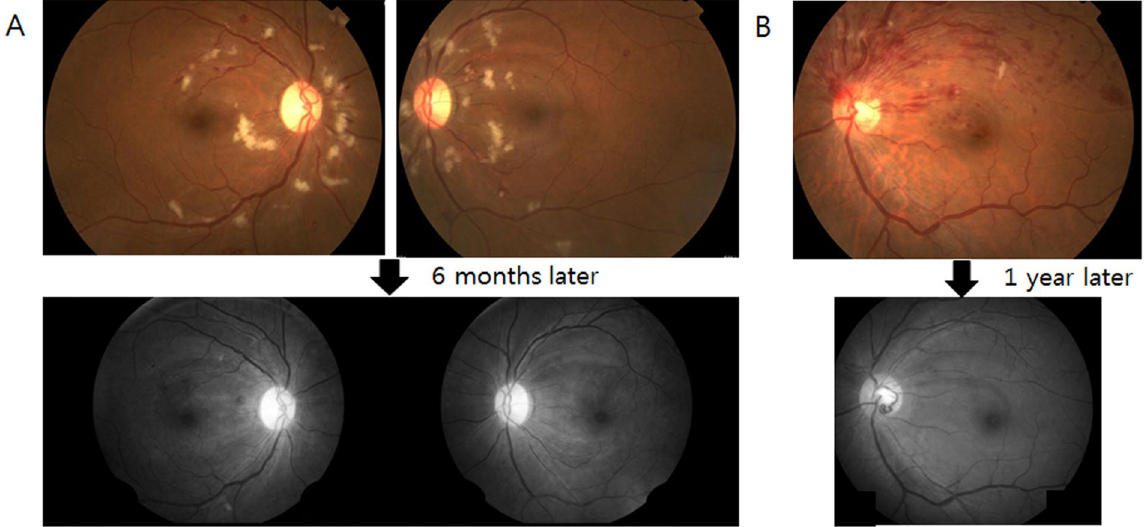
Figure 4. Two cases with multiple retinal nerve fiber layer (RNFL) defects related to retinal vascular disease. ( A ) A 43-year-old female with moderate non-proliferative diabetic retinopathy, hypertensive retinopathy, and a history of cerebral infarction presented with multiple cotton-wool spots in both eyes. Six months later, multiple RNFL defects occurred in both eyes. ( B ) A 42-year-old female with systemic hypertension showed multiple RNFL defects at the sector of the optic disc corresponding to the location where a branched retinal vein obstruction had